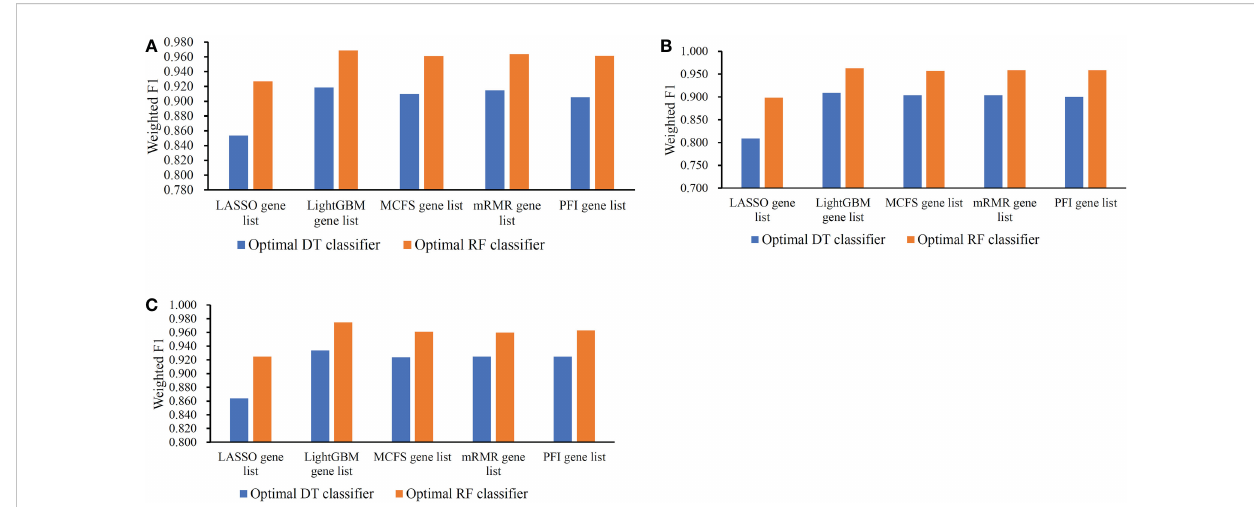
FIGURE 5 Bar chart to show weighted F1 yielded by the optimal classi fi ers on different gene lists for three cell types. (A) Bar chart for B cell. (B) Bar chart for CD4 + T cell. (C) Bar chart for CD8 + T